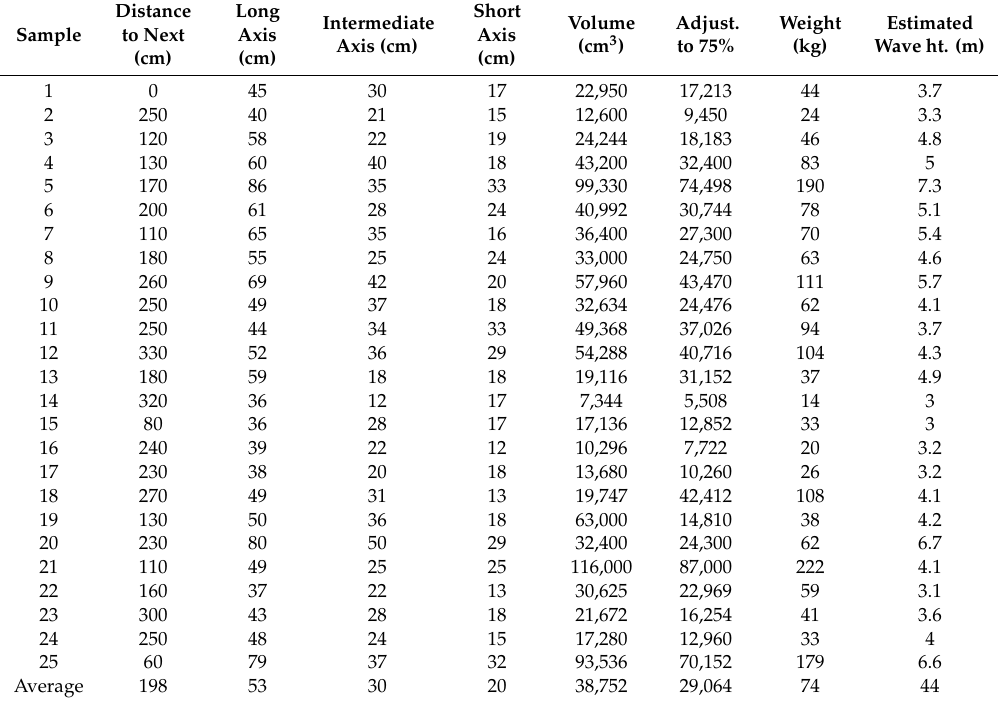
Table 3. Quantification of boulder size, volume and estimated weight from coastal bar samples through Transect 1c (continuation from 1b east of El China). The laboratory result for density at 2.55 gm / cm 3 is applied uniformly in order to calculate wave height for each boulder.